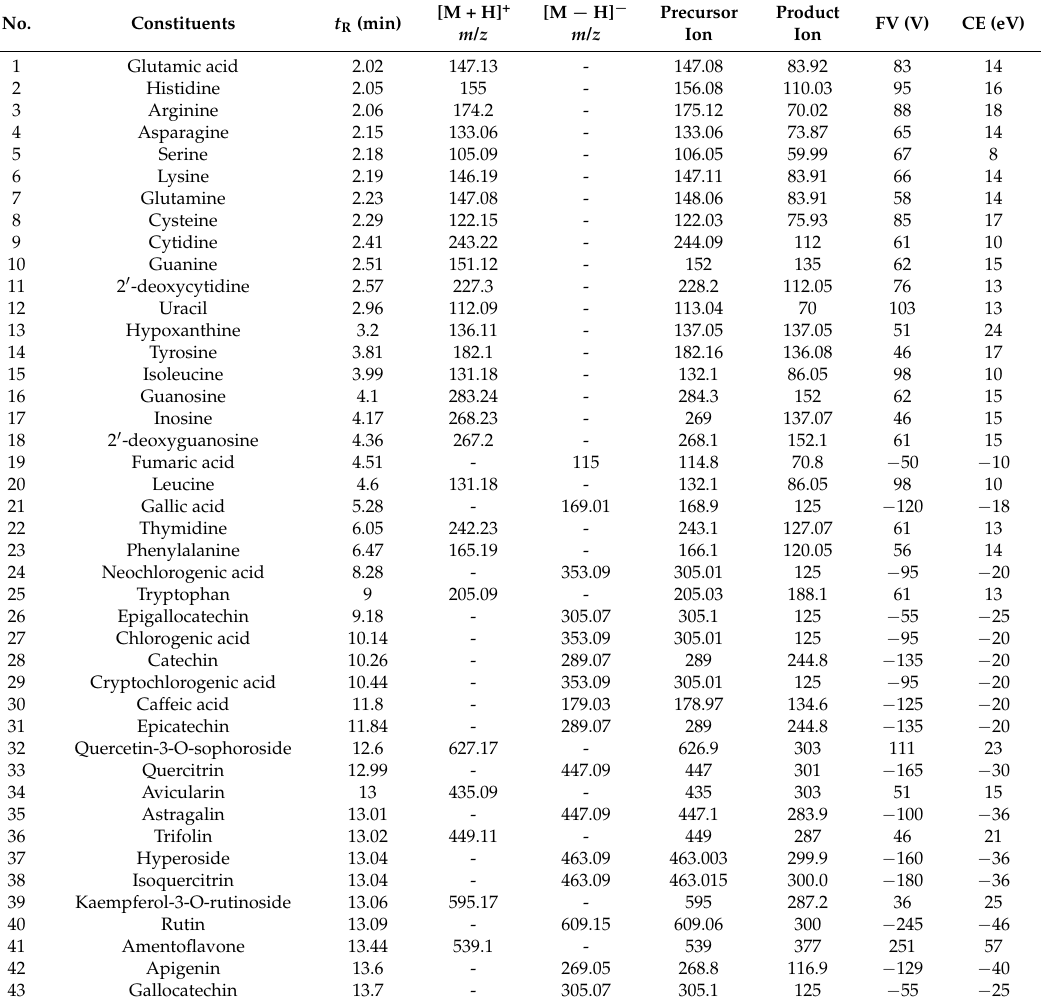
Figure 1. Multivariate statistical analysis of 41 samples of Apocyni Veneti Folium (AVF) and Poacynum hendersonii (PHF). Principal component analysis (PCA) scores plot ( A ) and PCA loading plot ( B ) of samples. Table 1. Precursor/product ion pairs and parameters for MRM (multiple reaction monitoring) of the target compounds.